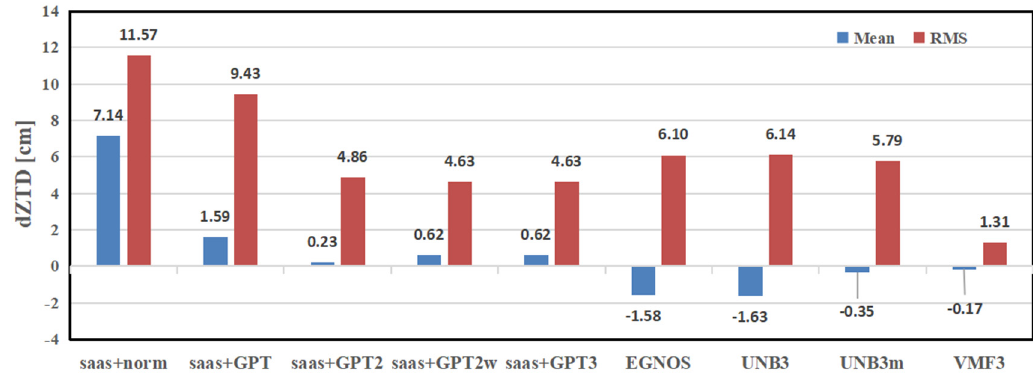
Figure 2. Mean and RMS between the IGS ZTD and the 9 models (saas+norm/GPT/GPT2/GPT2w/GPT3, EGNOS, UNB3, UNB3m, VMF3). To evaluate the model accuracies in different seasons, dZTD means and RMSs by different models are calculated and summarized by using each 7 day period’s data, as shown in Figures 3 and 4.